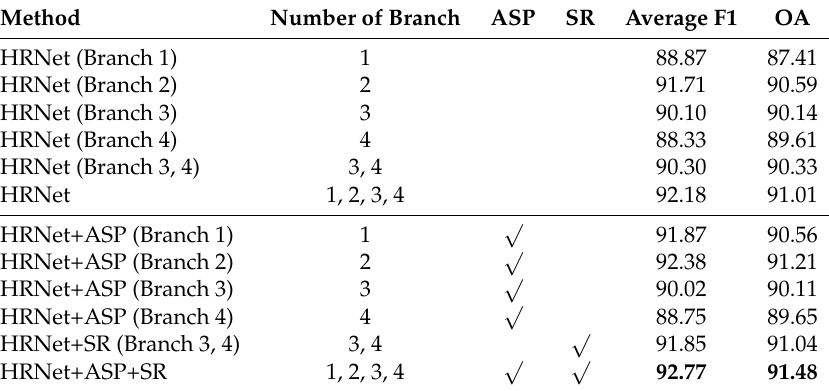
Table 1. Results of the ablation study on the Potsdam